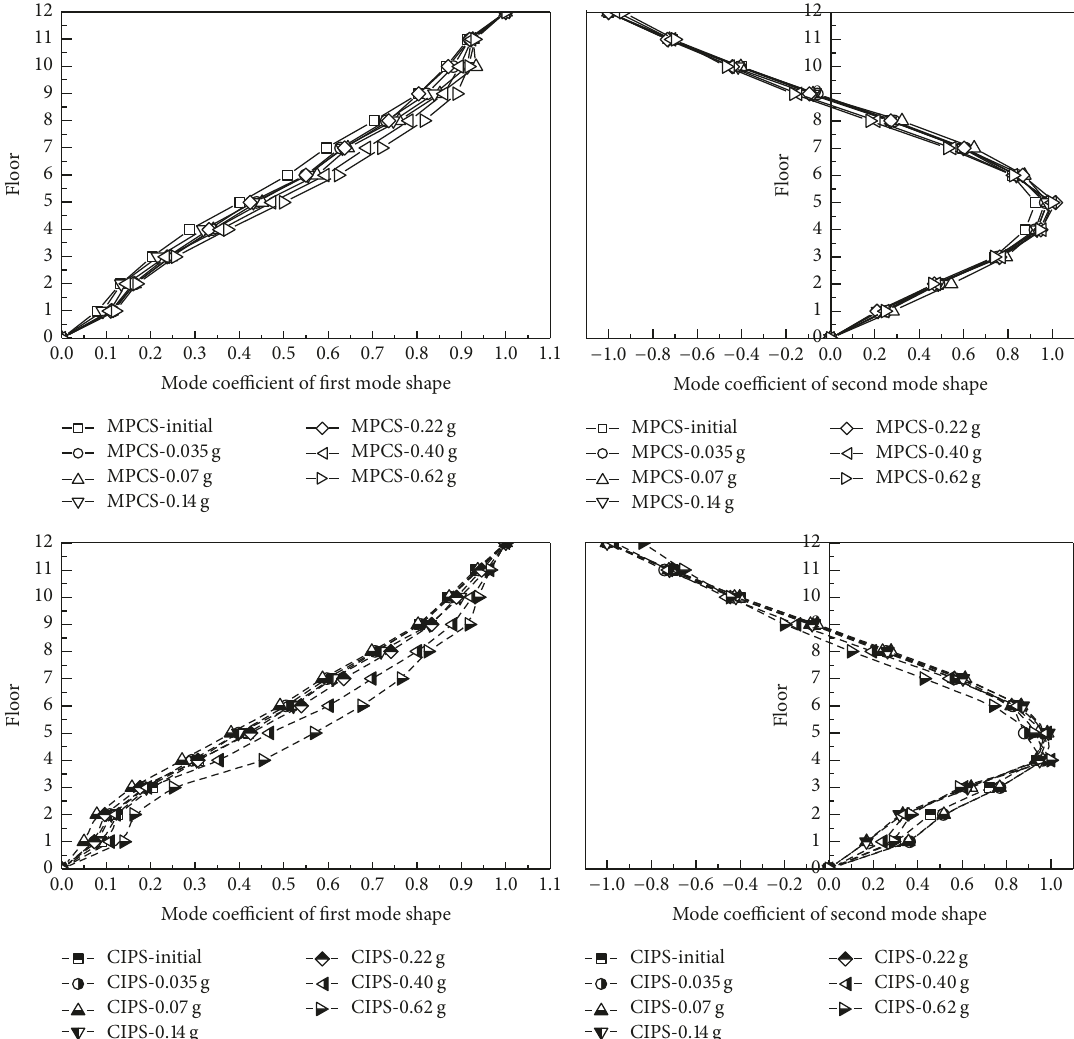
Figure 9: Mode shapes of CIPS and